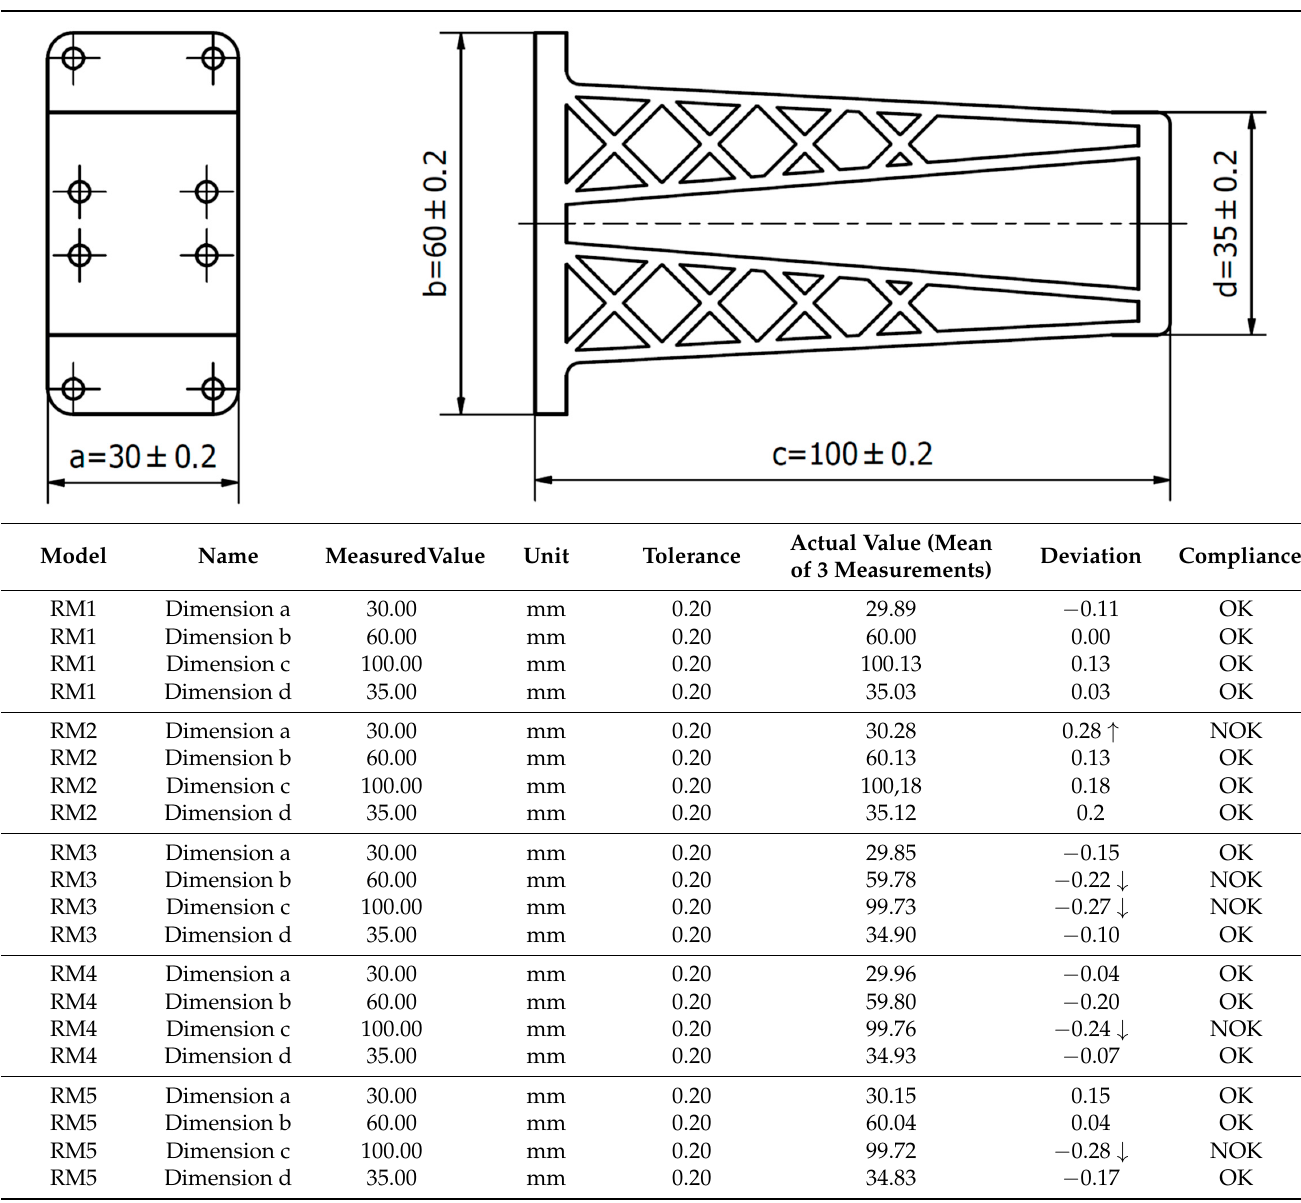
Table 3. Results of model dimension control.